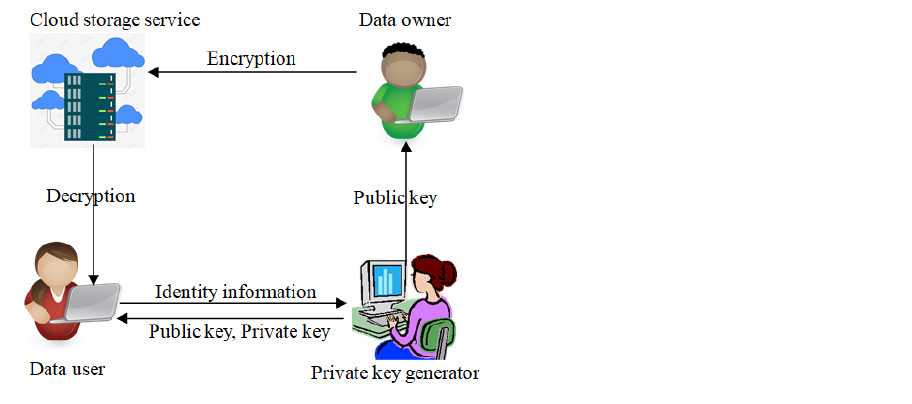
Figure 2. T he system’ s framework of anonymous leakage-resilient IBBE in cloud storage services. Figure 2. The system’s framework of anonymous leakage-resilient IBBE in cloud storage